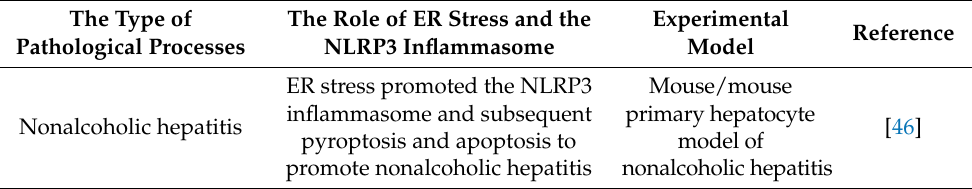
Table 1. Summary of the roles of endoplasmic reticulum stress and NLRP3 inflammasome in liver